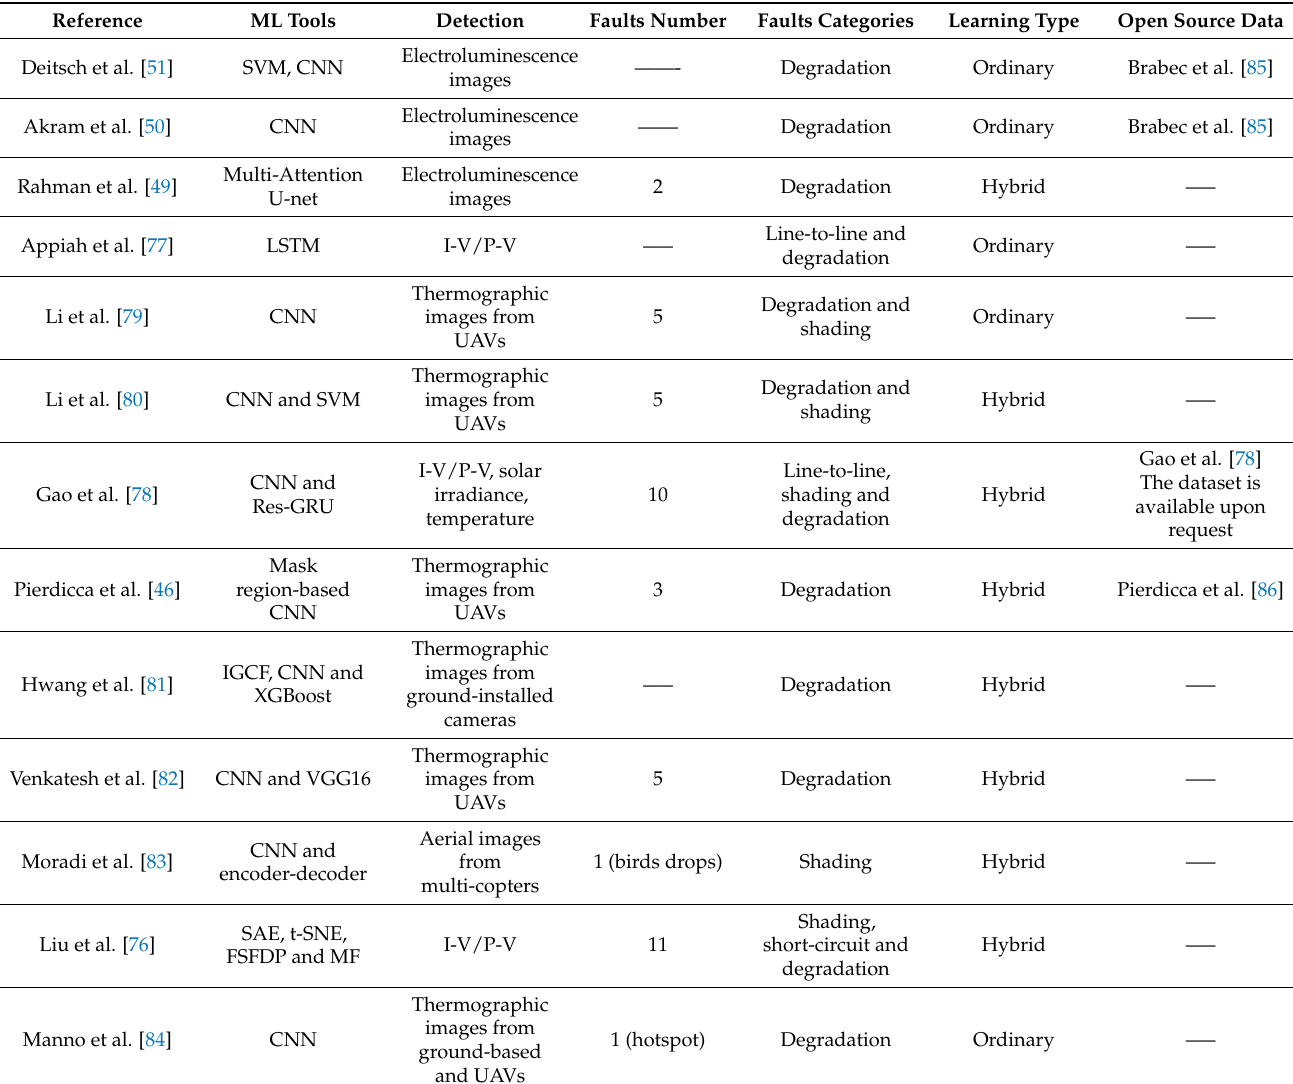
Table 2. Advanced DL methods for CM of PV